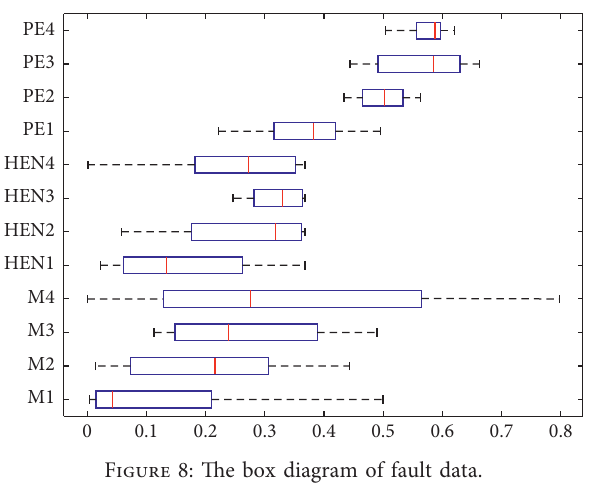
Figure 8: The box diagram of fault data.